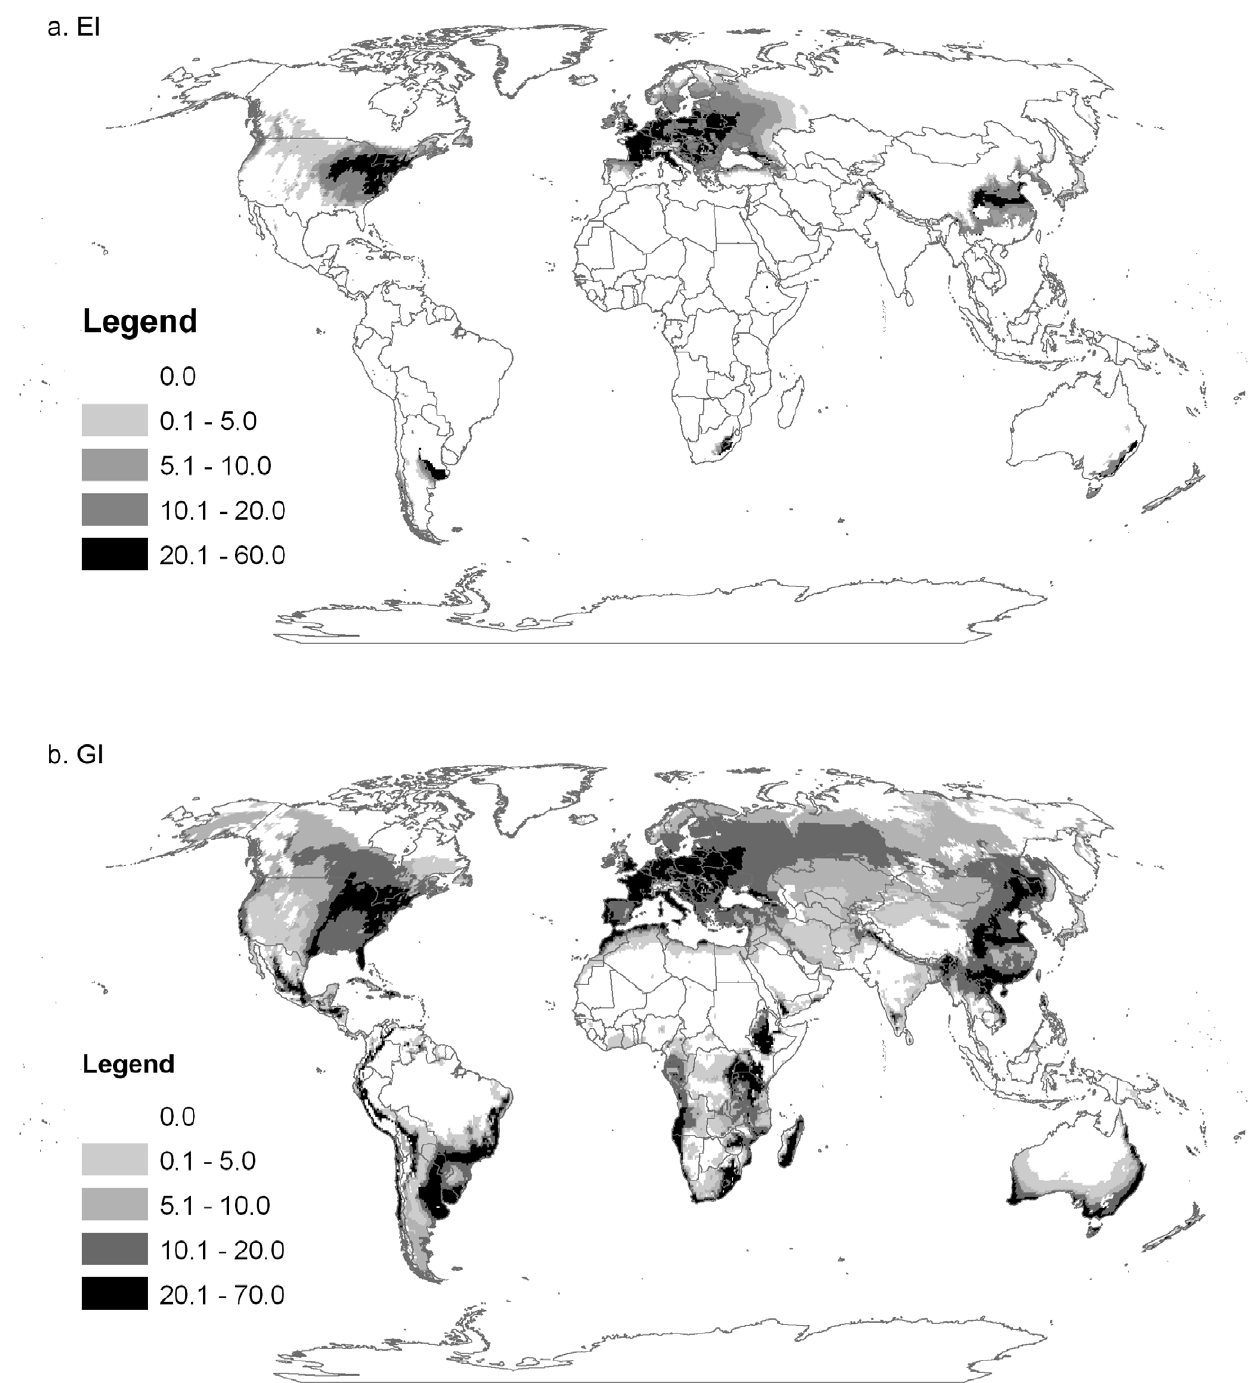
Figure 3. The world, showing the climate suitability for the oat aphid Rhopalosiphumpadi estimated using a CLIMEX model. The model was parameterised for the sexual mode of reproduction and shows; (a), the Ecoclimatic Index, indicating the potential distribution of sexual populations (potential for year round persistence EI . 0); and (b), the annual Growth Index GI A indicating areas that are suitable for growth at some point during the year (GI A . 0). This model does not include data about the presence of a suitable primary host plant.